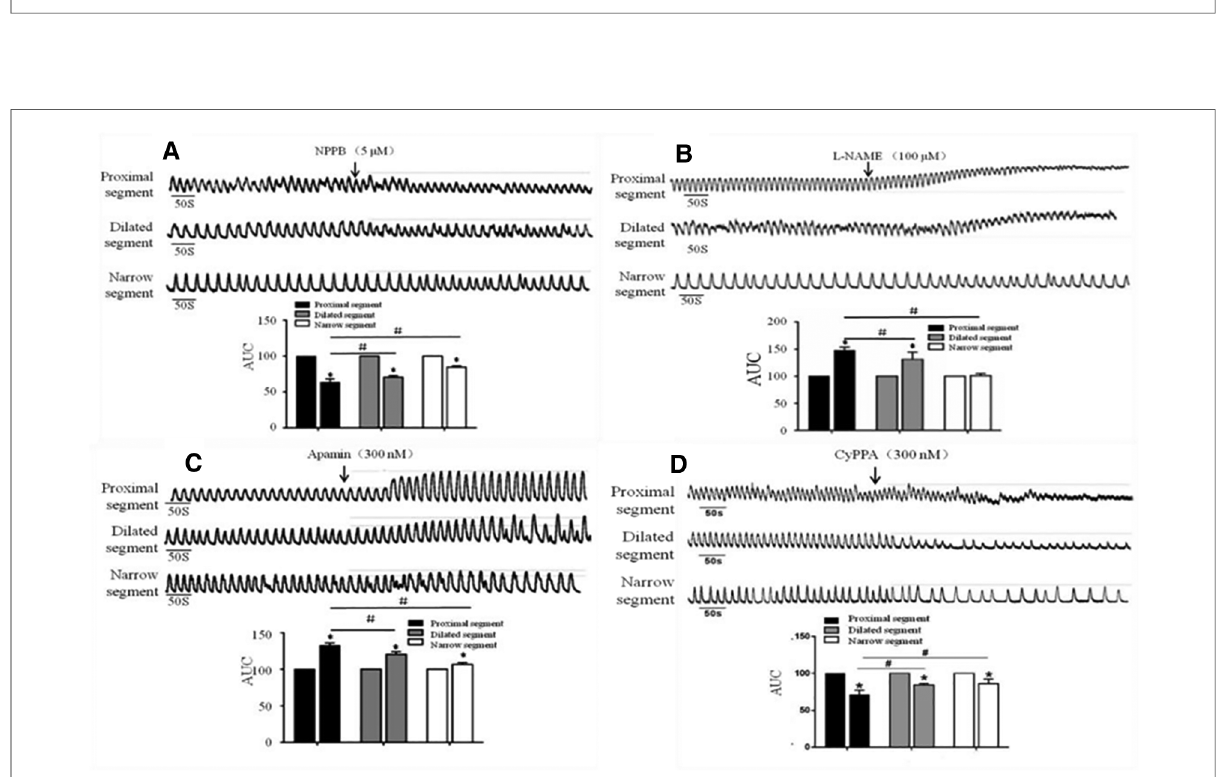
FIGURE 5 Effects of NPPB, L-NAME, apamin, and CyPPA on the smooth muscle contractions of the colon. A signi fi cant response was observed in the proximal segment compared to that in the narrow segment after the administration of ( A ) NPPB, ( B ) L-NAME, ( C ) Apamin, and ( D ) CyPPA, *<0.05 vs. before drugs; #<0.05 vs. proximal